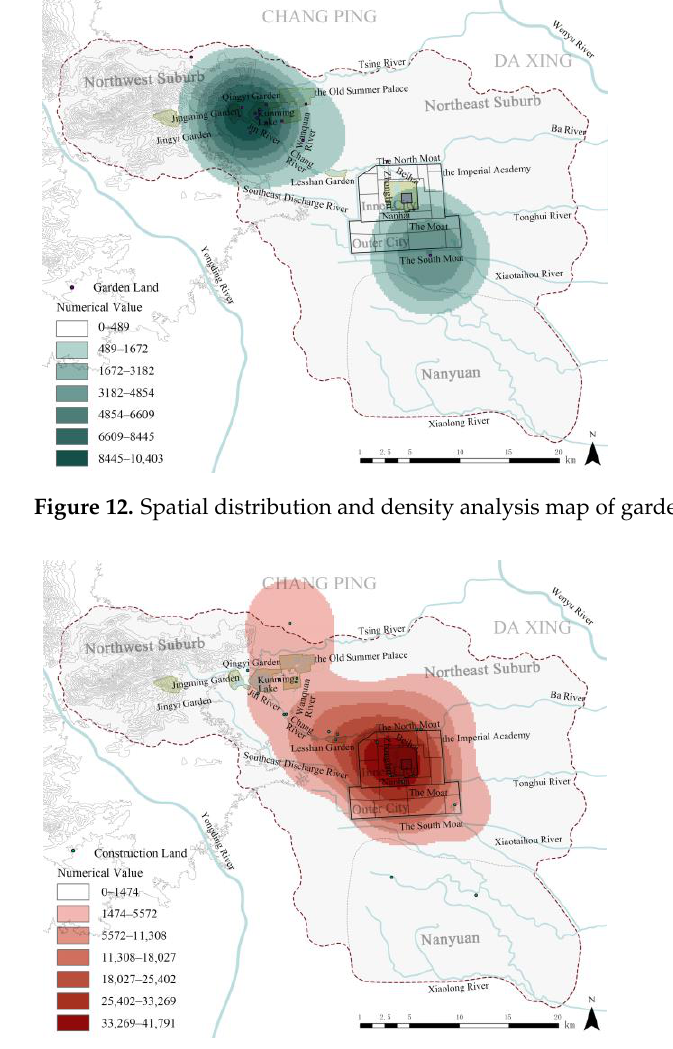
Figure 13. Spatial distribution and density analysis map of construction land.